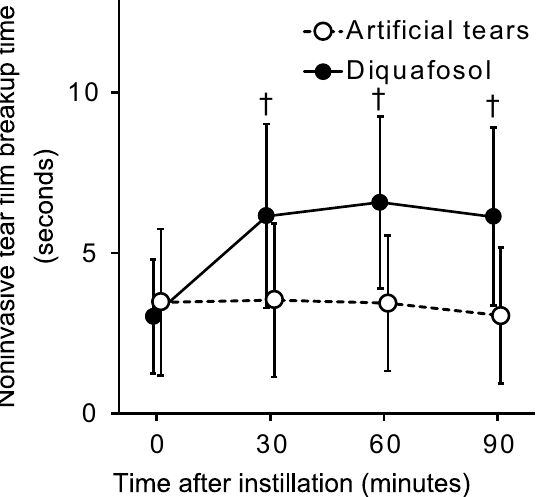
Figure 3. Time course for noninvasive breakup time of the tear film before and after artificial tear or diquafosol administration. Data are shown as means ± standard deviations ( n = 47). † Adjusted P < 0.001 versus corresponding preadministration (time 0) value (Wilcoxon signed-rank test with Bonferroni’s adjustments for three